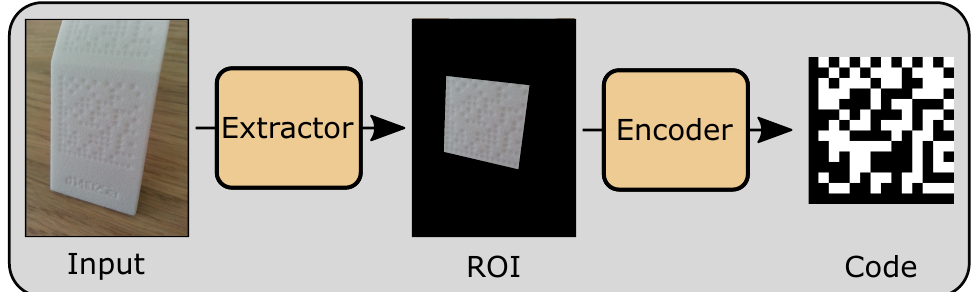
Figure 1. On the left side, a direct-part marking on an SLS part is presented. The same code is shown on the right side as standard data matrix code after passing the presented deep-learning-based processing